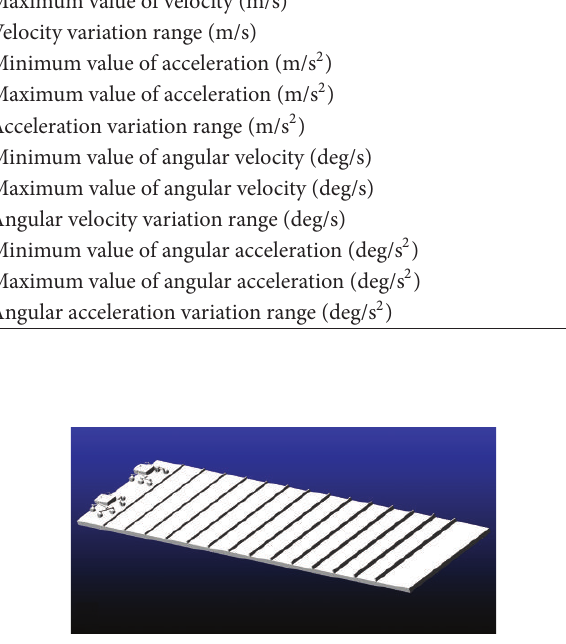
Figure 9: Kinematical simulation in scenario 2.